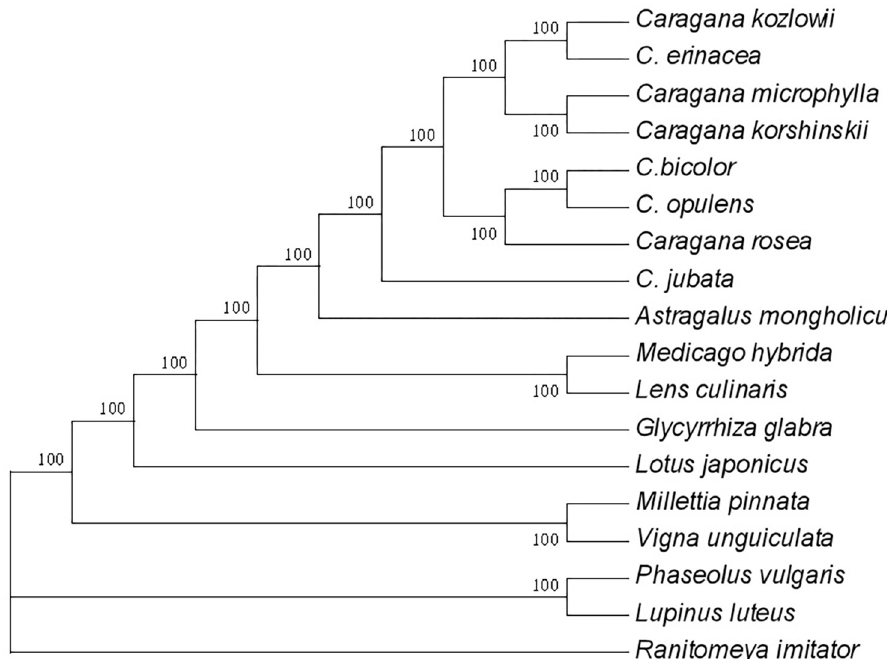
Fig 5. NJ tree based on chloroplast genomes of the Fabaceae